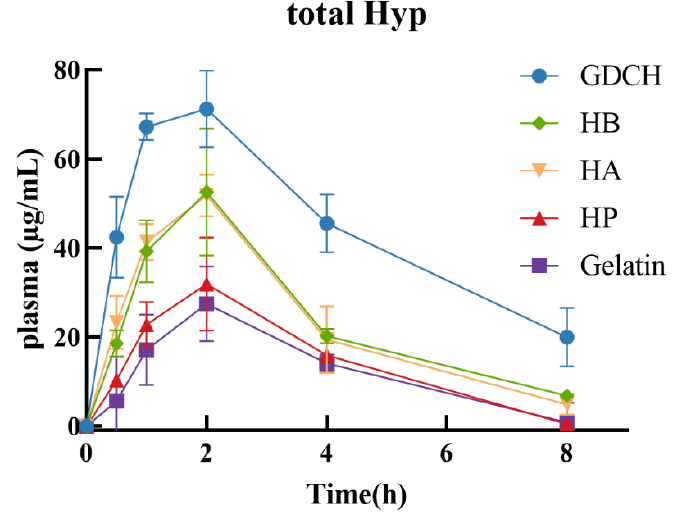
Figure 3. The concentration of total Hyp in rat plasma after oral ingestion (2.4 g/kg). Symbols: gelatin ( (cid:4) ), HP ( (cid:78) ), HA ( (cid:72) ), HB ( (cid:117) ), GDCH ( (cid:108) ). Data were shown as mean ± SD, n = 6. HA: alkaline protease hydrolysate; HP: pepsin hydrolysate; HB: bromelain hydrolysate; GDCH: ginger protease-degraded collagen hydrolysate. Table 1. Pharmacokinetic parameters of the total Hyp in rat plasma after ingestion of gelatin and hydrolysates (HA, HB, HP, and GDCH).